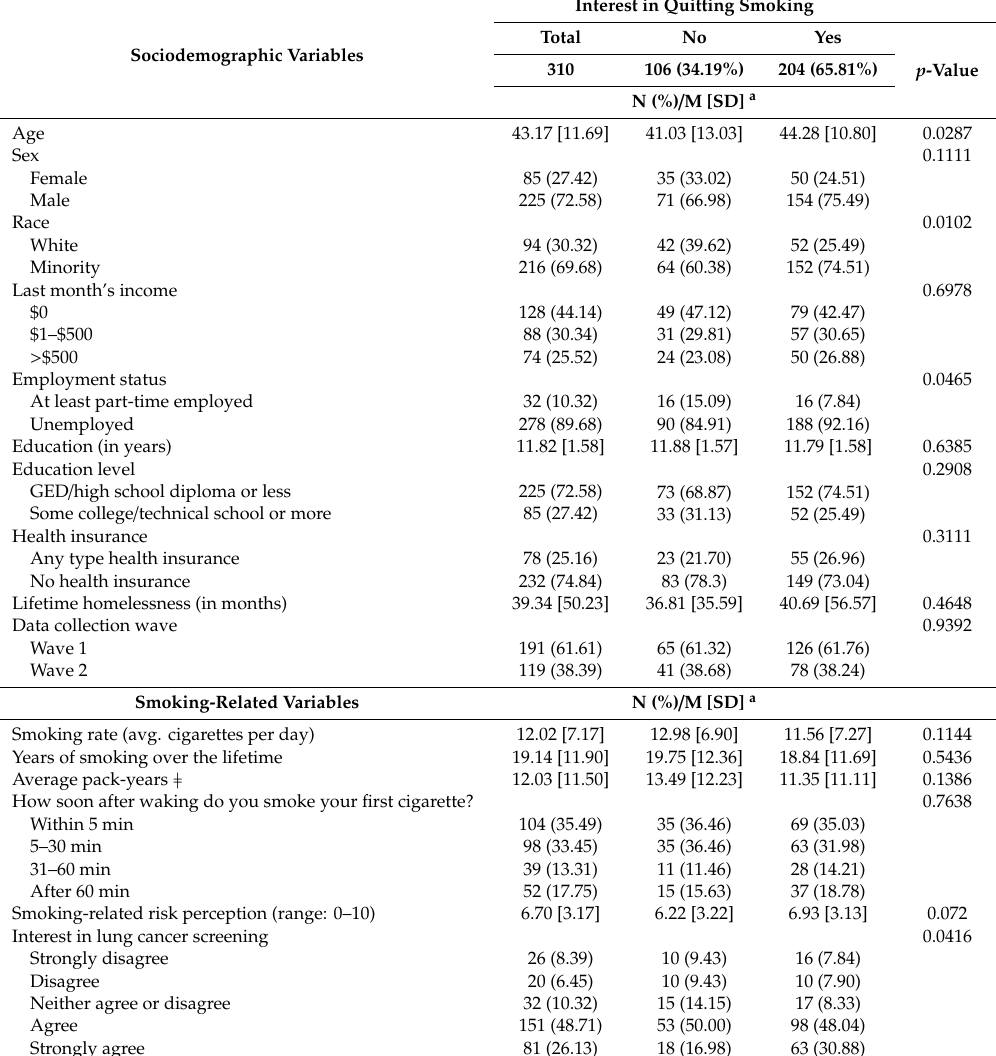
Table 1. Participants’ characteristics by interest in quitting